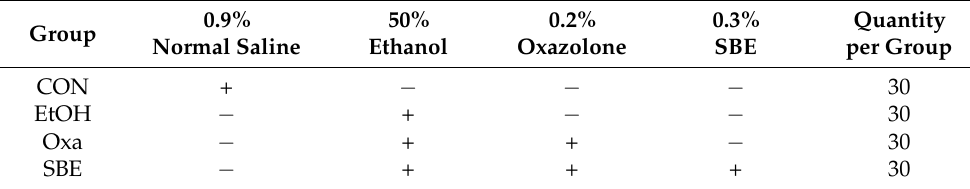
Table 1. Oxazolone-induced intestinal oxidative stress in adult zebrafish. 0.9% 50% Group Normal Saline